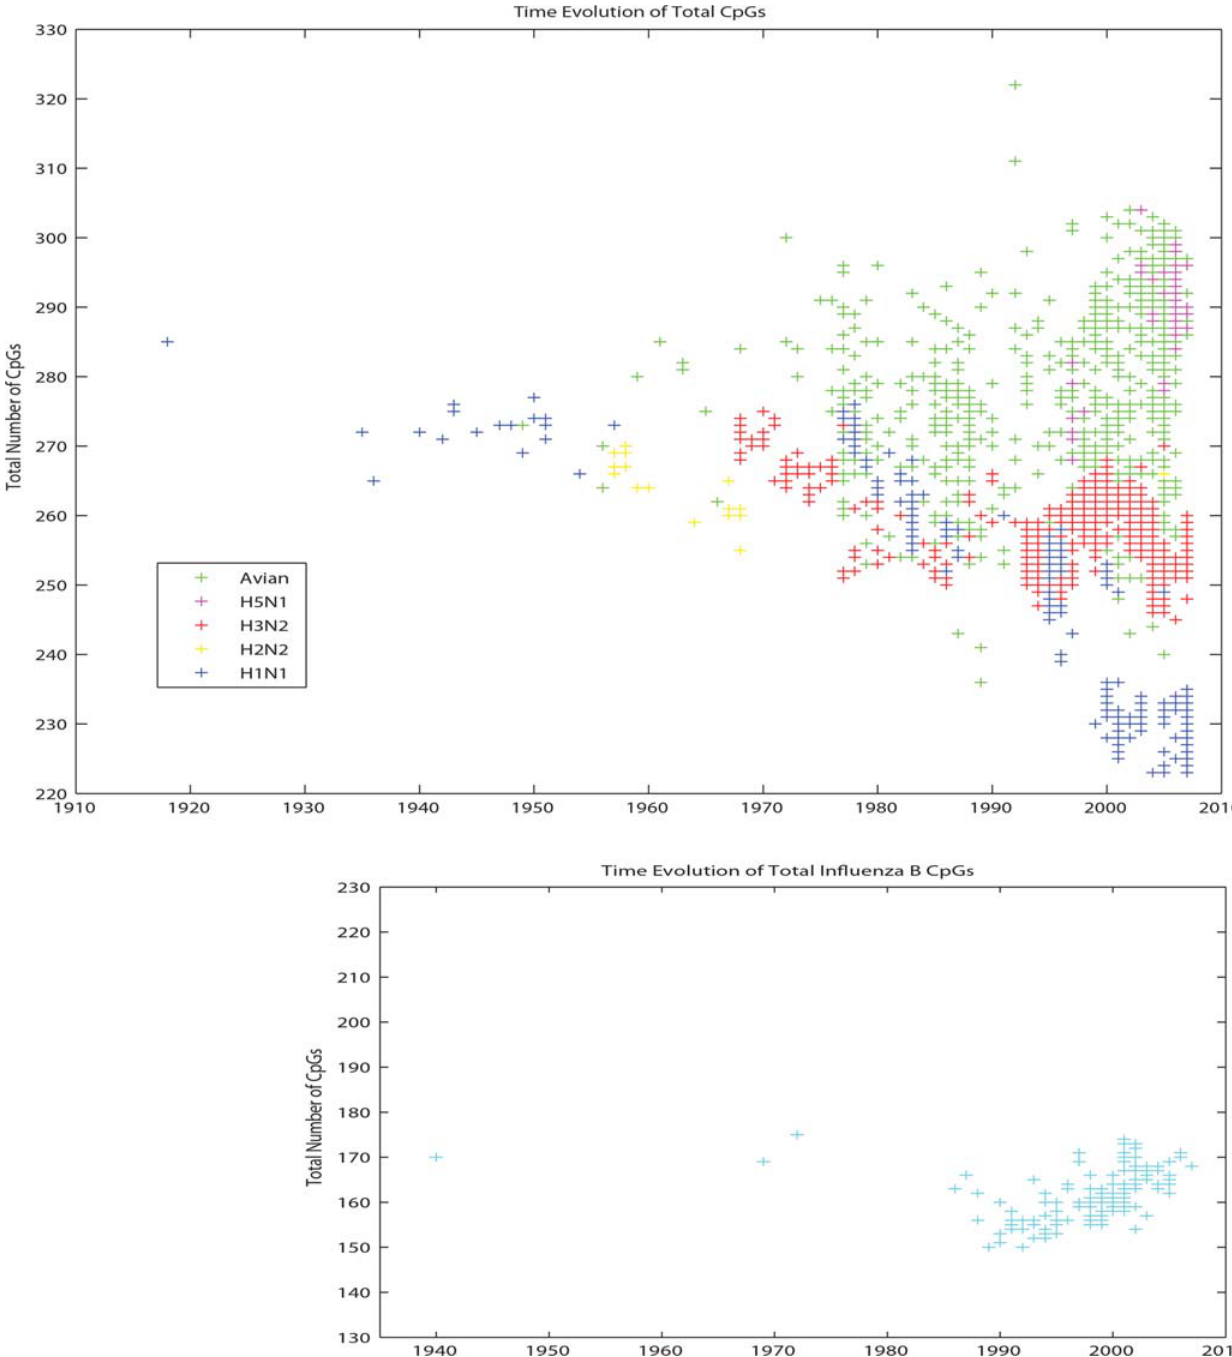
Figure 3. Evolution of the number of CpG motifs in influenza A and B. Top: Evolution of the number of CpGs in influenza A virus in time. When an influenza virus crosses from birds to humans the virus mimics the host genes by reducing the number of CpGs. Bottom: Evolution of the number of CpGs in influenza B virus in time.